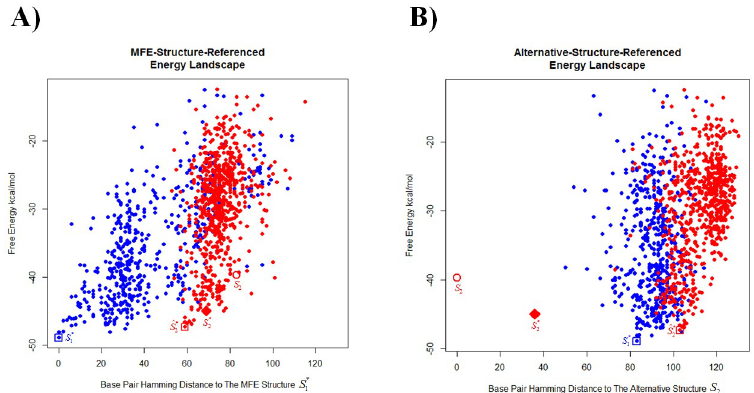
Fig 3. Energy landscape of tenA TPP. The open blue square represents the computed MFE structure S � circle, the actual alternative structure S 2 ; the solid red diamond, the CP-predicted alternative structure S � red square, the SC-predicted alternative structure ^ S � alternative clusters, respectively (see the Materials and methods section for details on our SC implementation). A) A standard depiction of an energy landscape, where the MFE structure S � B) The Alternative-Structure-Referenced (ASR) energy landscape, where the actual alternative structure S 2 provides the reference structure at distance 0. Some important base-pair Hamming distances can be read directly from Fig 2A and 2B: d f S ; S � g ¼ 83 (from both 2A and 2B); d 2 1 H f S � ; S g ¼ 36 (from 2B). and d 2 2 H